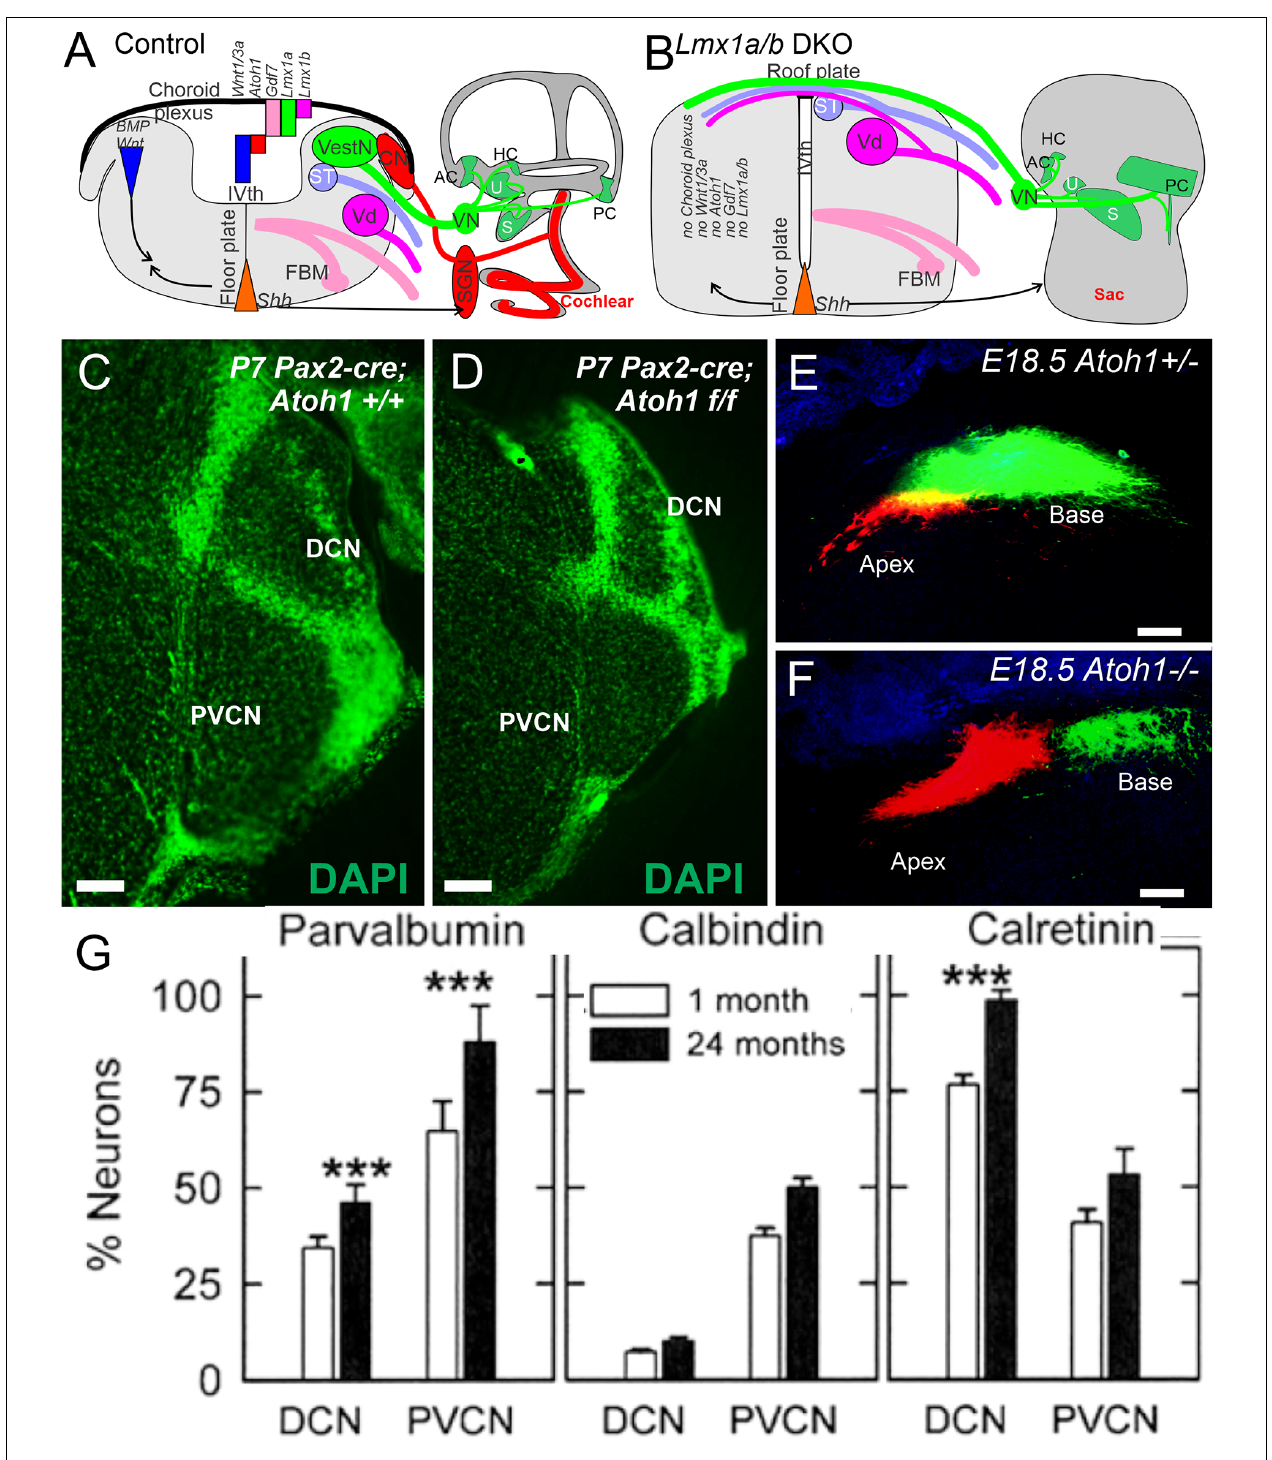
FIGURE 3 | Cochlear nuclei depend on Lmx1a/b , upstream of Gdf7 , Atoh1 , and Wnt3a (A) . In the absence of Lmx1a/b neither cochlear hair cells, spiral ganglion neurons, nor cochlear nuclei develop (B) . The choroid plexus is replaced by a roof plate that allows fibers to cross to the contralateral side (A,B) . Cochlear nuclei are smaller in a conditional deletion of Atoh1 using Pax2-cre (C,D) . In Atoh1 -null mice, there is a normal central projection of SGNs without either peripheral hair cells or cochlear nuclei (E,F) . Expression of Parvalbumin, Calbindin and Calretinin showing upregulation in the cochlear nuclei at the level of DCN and PVCN areas that increase in some but not all neurons (G) . Modified after Idrizbegovic et al. (2006), Elliott et al. (2017, 2021b), and Chizhikov et al. (2021). Scale bars: 100 µ m (C–F) . *** indicates significance.